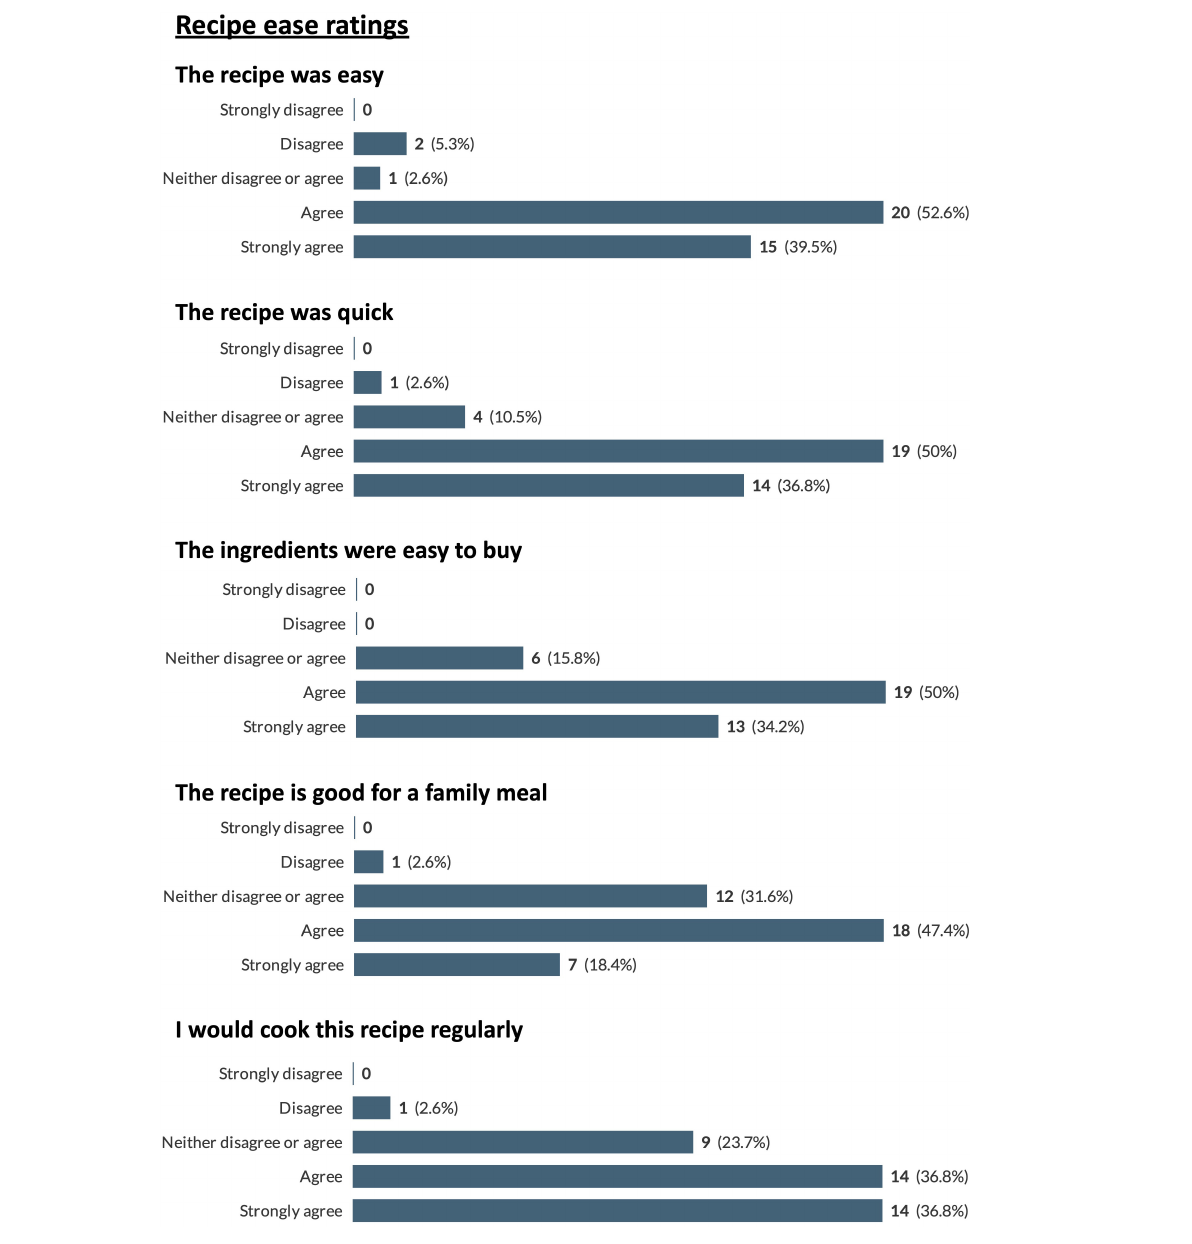
FIGURE5 Pooled participant responses to questions relating to ease of preparation of the proposed recipes. Displayed as number and (percentage) of responses to each answer option (e.g., 100% would represent that all this question’s responses chose that